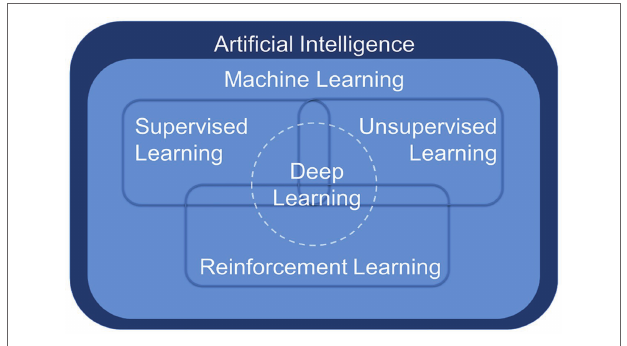
FIGURE 1 | The relationship among artificial intelligence, machine learning, and deep